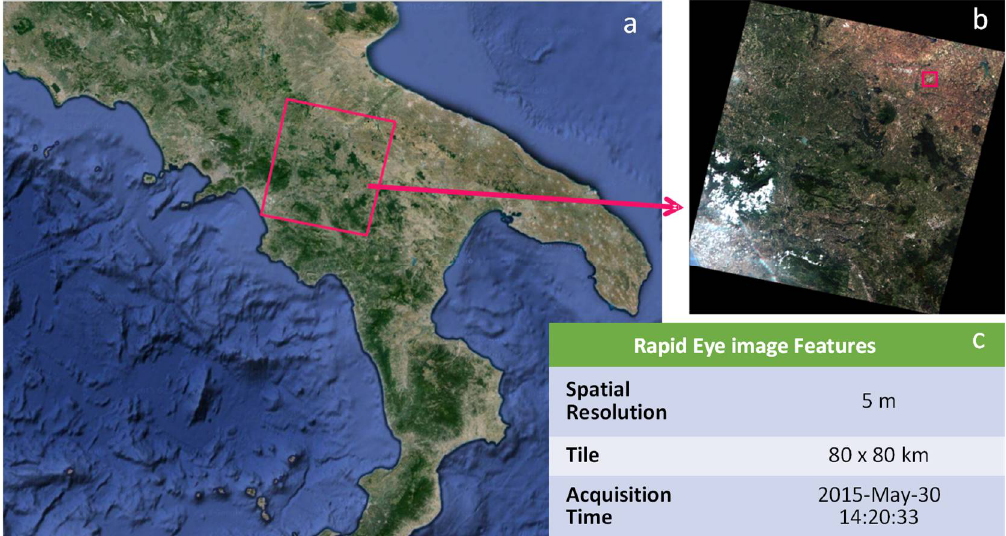
Figure 5. Rapid Eye image characteristics: ( a ) framing of the image tile, ( b ) location of the study sites within the tile, and ( c ) principal features of the acquired image.